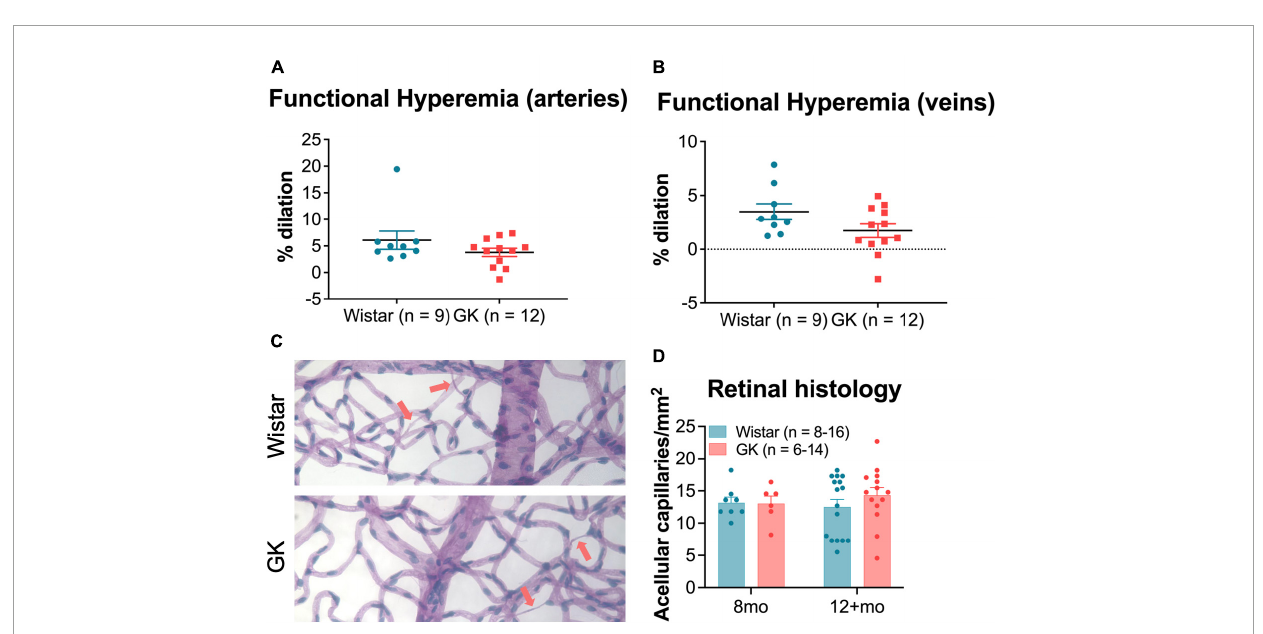
FIGURE6 Goto-Kakizaki rats do not show changes in vascular function by 8 months or in vascular structure by 8–12 months. Functional hyperemia response (% dilation) in retinal arteries (A) and veins (B) at 8 months of age. (C) Representative vascular histology images from GK rats and Wistar controls. Arrows indicate acellular capillaries. (D) Average number of acellular capillaries/mm 2 as counted in vascular histology images at 8 months and 12+ months. Results expressed as mean ± SEM.